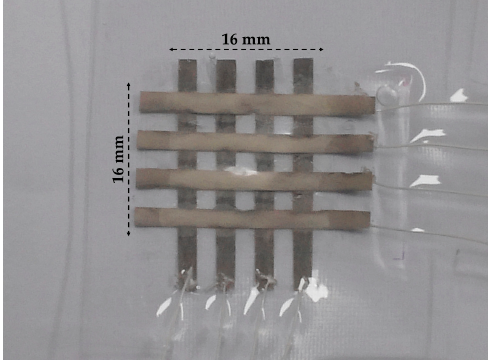
Figure 3. 4 × 4 digital type tactile sensor.